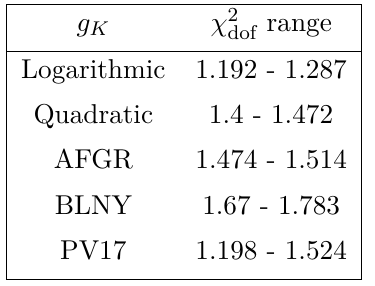
values for different nonperturbative g dof